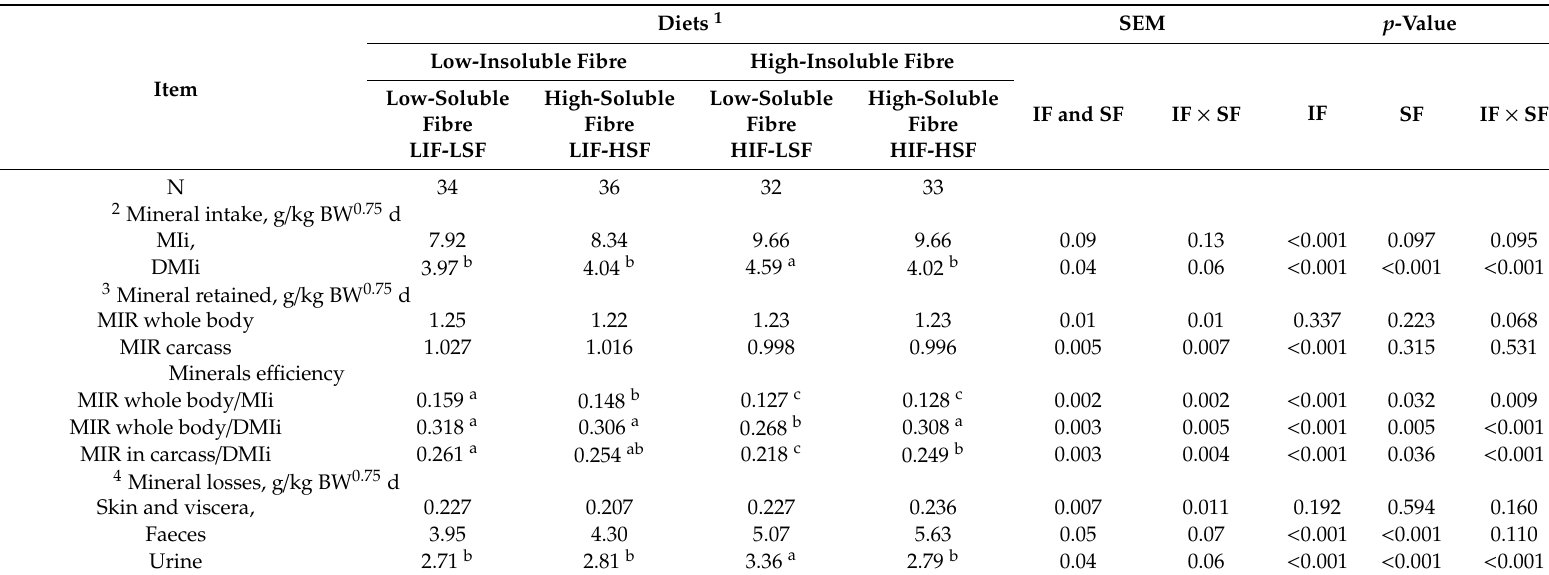
Table 6. E ff ect of dietary level of insoluble and soluble fibre on mineral (MI) balance from 28 to 62 days of age. Diets 1 SEM p Item